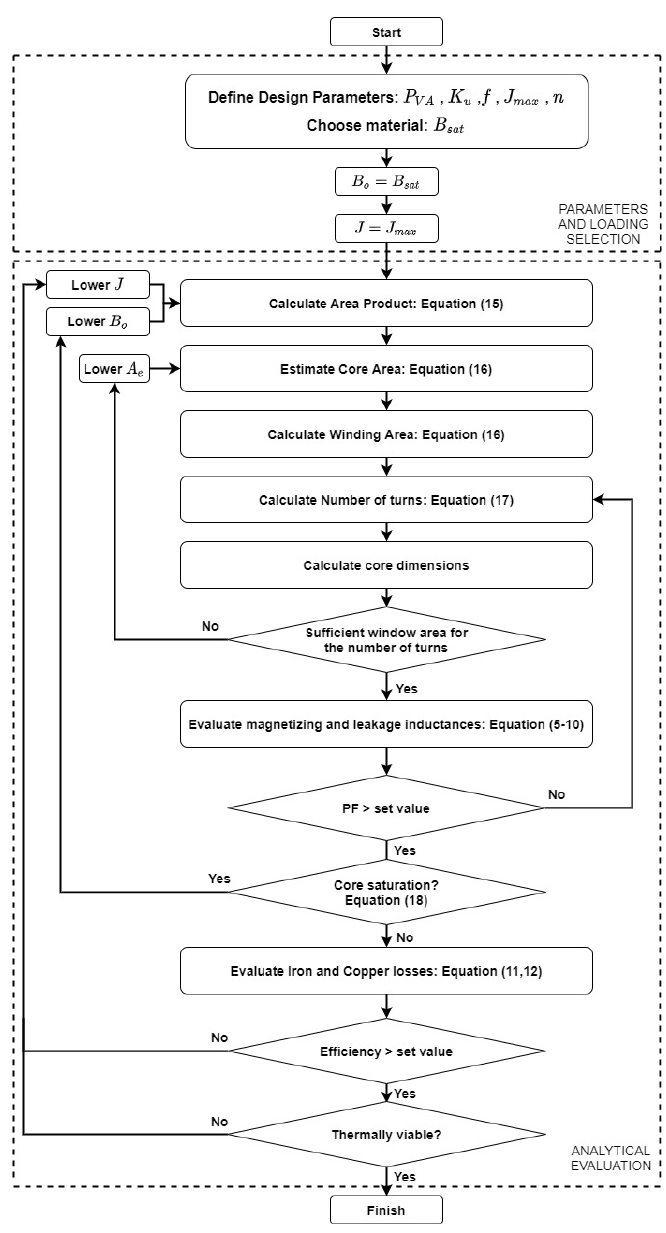
Figure 4. Design procedure for a single-phase rotary